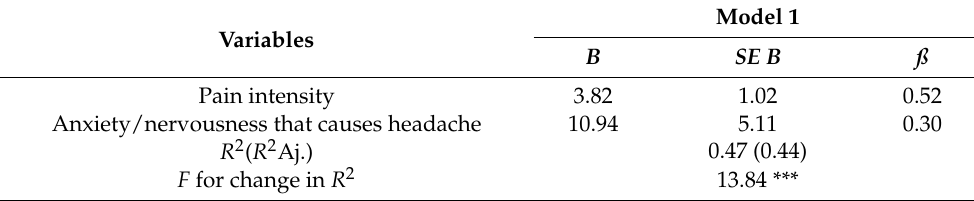
Table 4. Variables that contribute to psychological inflexibility in pain in TMD-headache group.